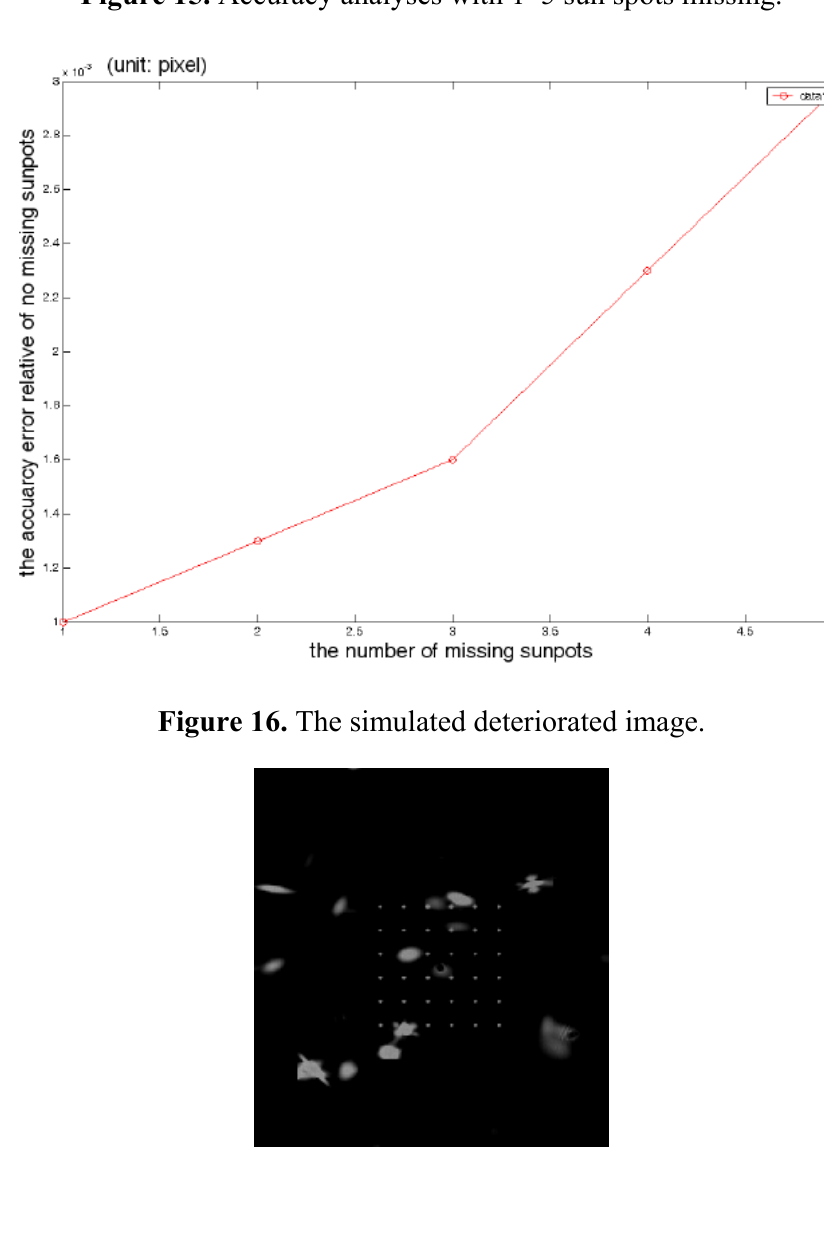
Figure 15. Accuracy analyses with 1–5 sun spots missing.